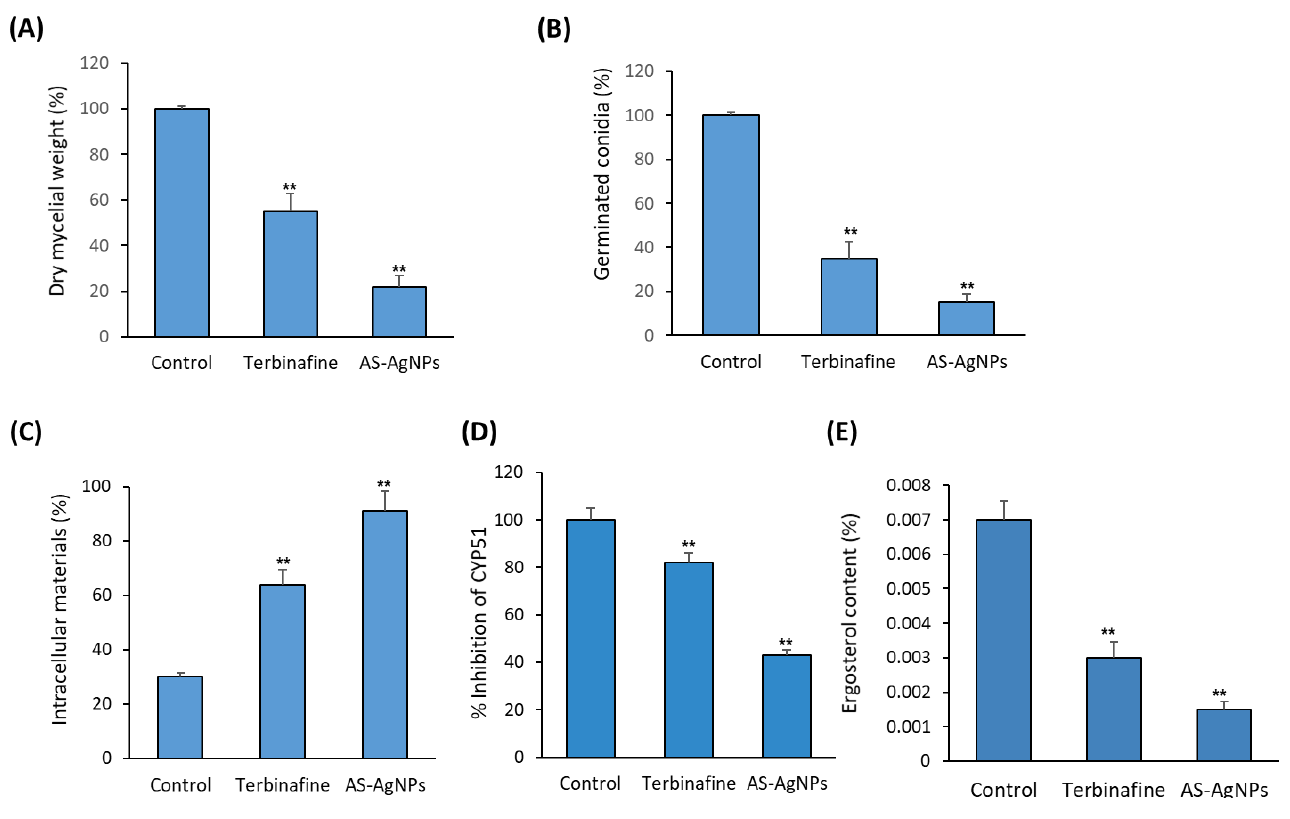
Figure 4. Effect of AS-AgNPs on mycelial growth and cell membrane integrity of T. rubrum . (A) Percentage of dry mycelial weight produced by T. rubrum in the absence (control) and presence of terbinafine (MIC: 256 μg/mL) and AS - AgNPs (MIC: 128 μg/mL). ( B ) Percentage of conidial germination of T. rubrum in the absence (control) and presence of terbinafine (256 μg/mL) and AS -AgNPs (128 μg/mL). ( C ) Rate of release of intracellular material from T. rubrum at 260 nm in the absence (control) and presence of terbinafinel (MIC: 256 μg/mL) and AS - AgNPs (MIC: 128 μg/mL). ( D ) Inhibition rate (%) of CYP51 enzyme in T. rubrum in the absence (control) and presence of terbinafinel (MIC: 256 μg/mL) and AS - AgNPs (MIC: 128 μg/mL). ( E ) Ergosterol content as percent of the wet weight of T. rubrum in the absence (control) and presence of terbinafinel (MIC: 256 μg/ mL) and AS-AgNPs (MIC: 128 μg/ mL). Values are mean ± SD of three independent experiments (** p < 0.05 compared to control non-treated cells).